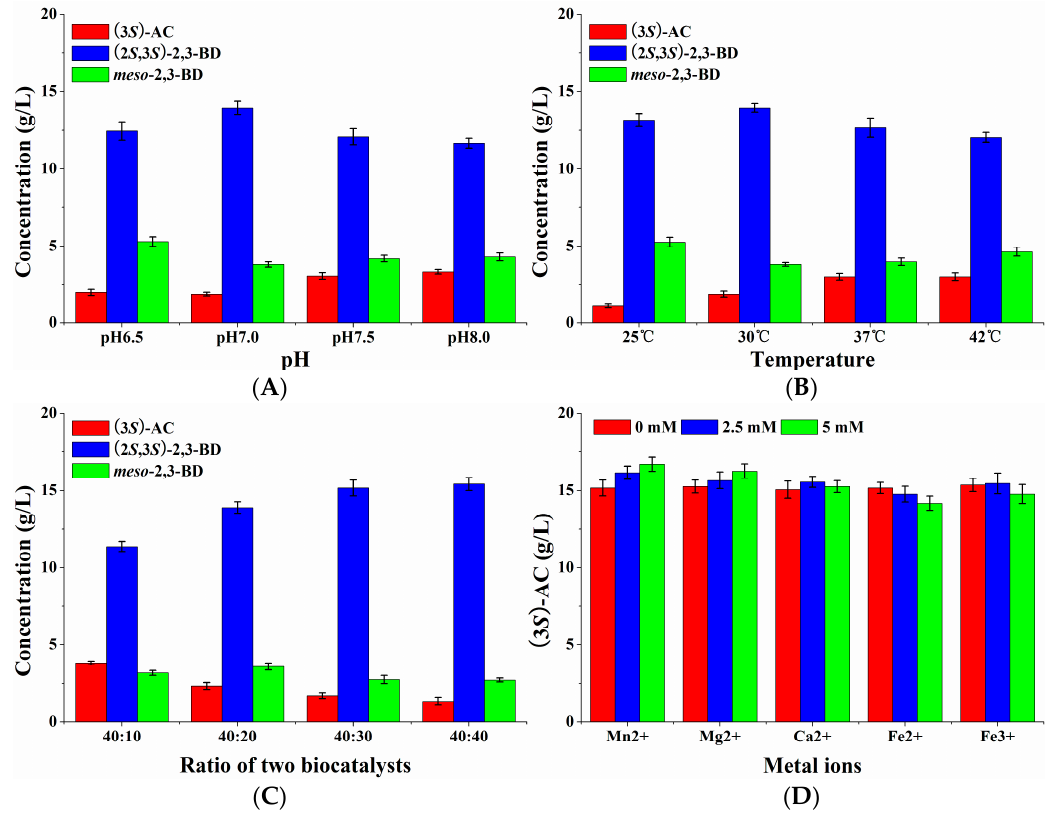
Figure 6. Effects of pH, temperature, ratio of induced E. coli (pET- rrbdh - nox - vgb ) cells to induced E. coli (pET- ssbdh - fdh ) cells, and metal ions on (2 S ,3 S )-BD production from meso -2,3-BD by synchronous catalysis. ( A ) pH; ( B ) temperature; ( C ) ratio of E. coli (pET- rrbdh - nox - vgb ) cells to induced E. coli (pET- ssbdh - fdh ) cells; ( D ) different metal ions at the concentrations of 0, 2.5, and 5 mM. All the experiments were performed in triplicate in 100 mL flasks containing 10 mL reaction solution for 6 h.